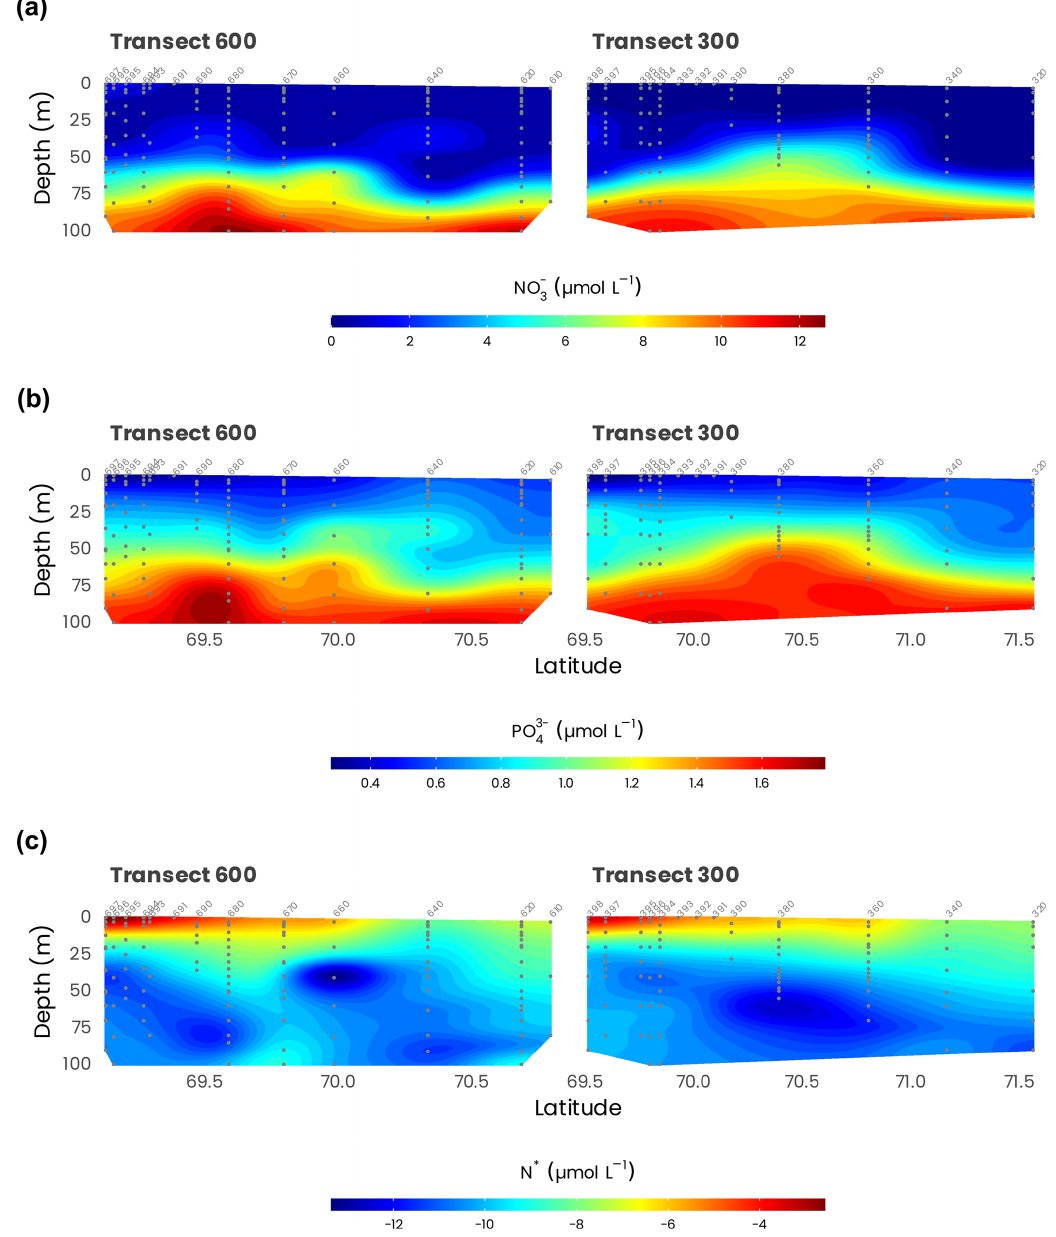
− and (b) PO 3 − measured from Niskin bottles (gray dots) along transects 600 and 300. (c) N ∗ defined Figure 8. Cross-sections of (a) NO 3 4 as N − rP , with r = N/P = 13 . 1 (see the text for the details). Station numbers are identified in light gray on top of each panel.